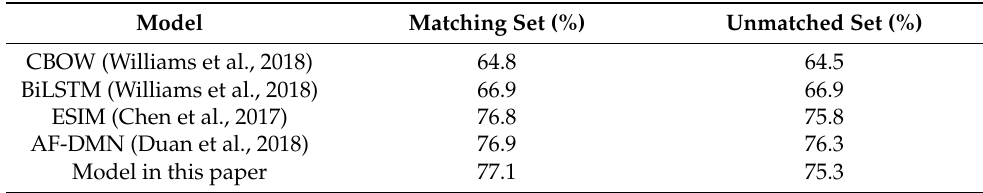
Table 5. Accuracy of each model on Multi-NLI